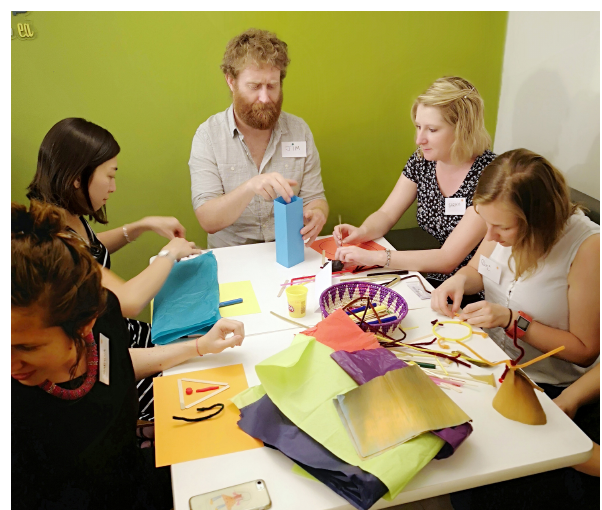
Figure 3. Creative networking in action with participants from mixed disciplinary backgrounds exploring what risk communica- tion meant to